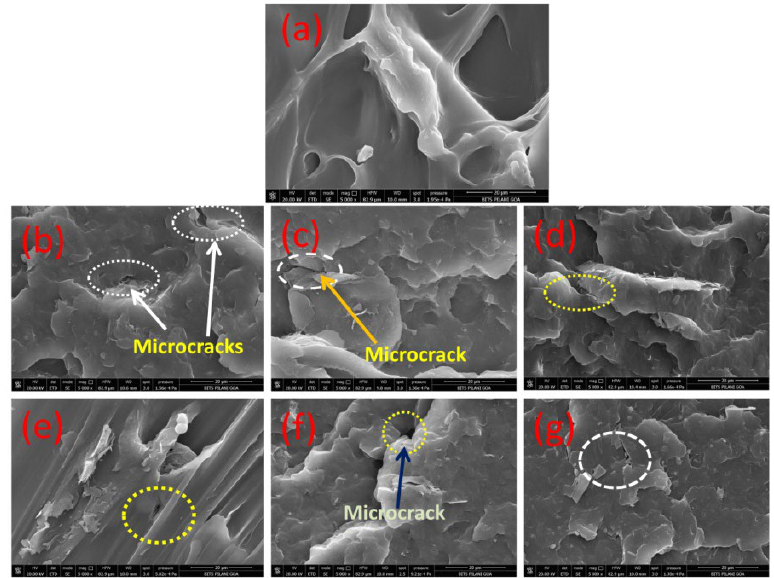
Figure 8. Impact fracture surface morphology of ( a ) virgin PP, ( b – d ) PP-H5 and ( e – g ) PP-H15 nanocomposites containing 1, 2 and 3 wt.% GNPs at ×5000 magnification.